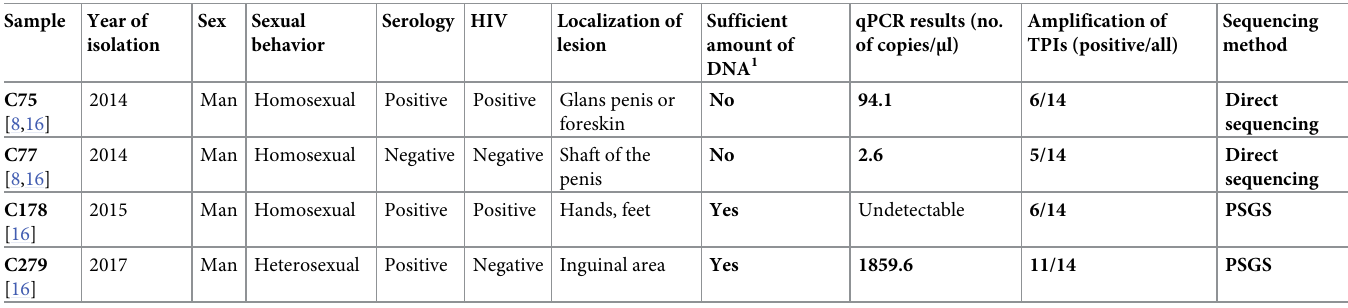
Table 1. Characteristics of bejel patients and the corresponding